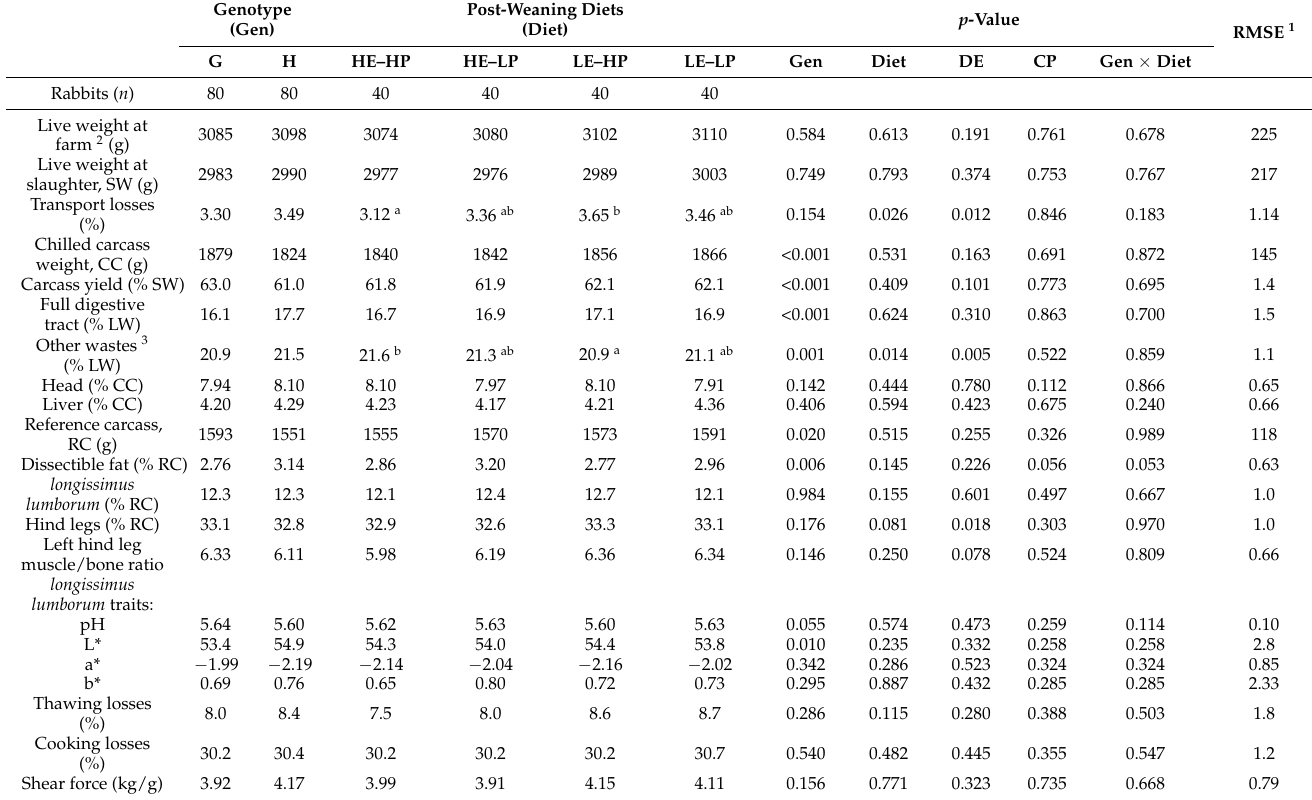
Table 6. Live weight, carcass yield, carcass dissection and meat quality of rabbits slaughtered